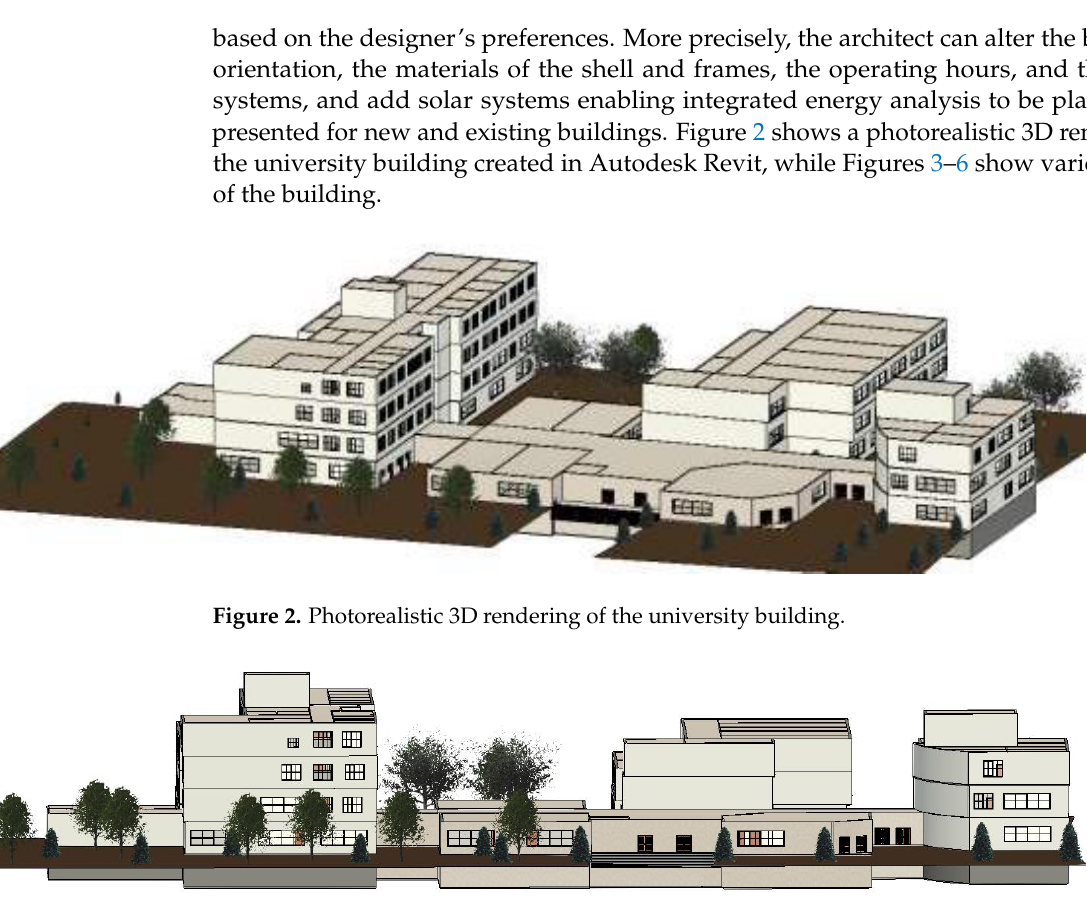
Figure 3. West view of the building.